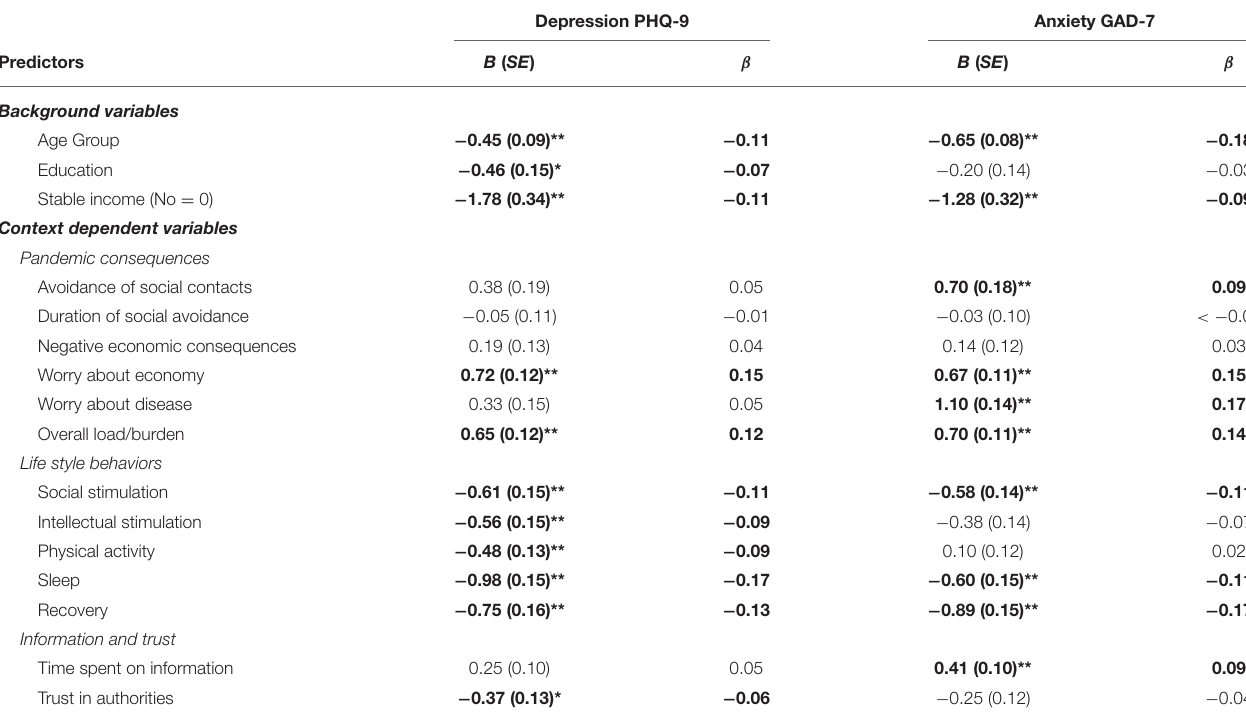
TABLE 6 | Linear regression for symptoms of depression (PHQ-9), symptoms of anxiety (GAD-7).